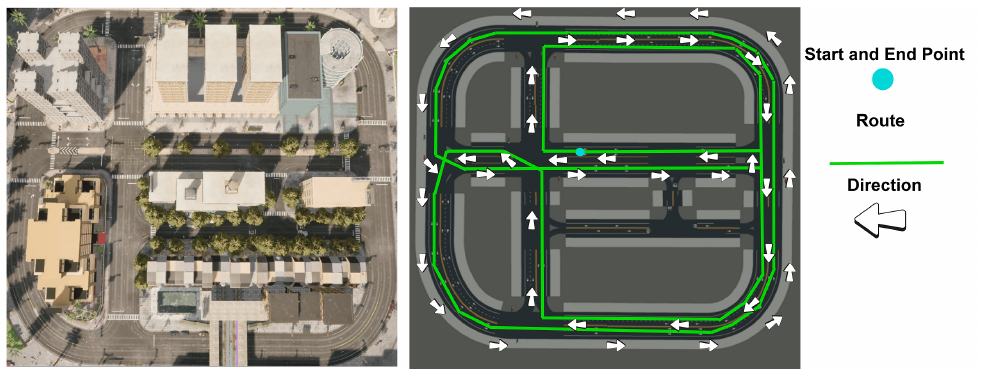
Figure 3. Map of the CARLA simulator used for driving simulation and the established